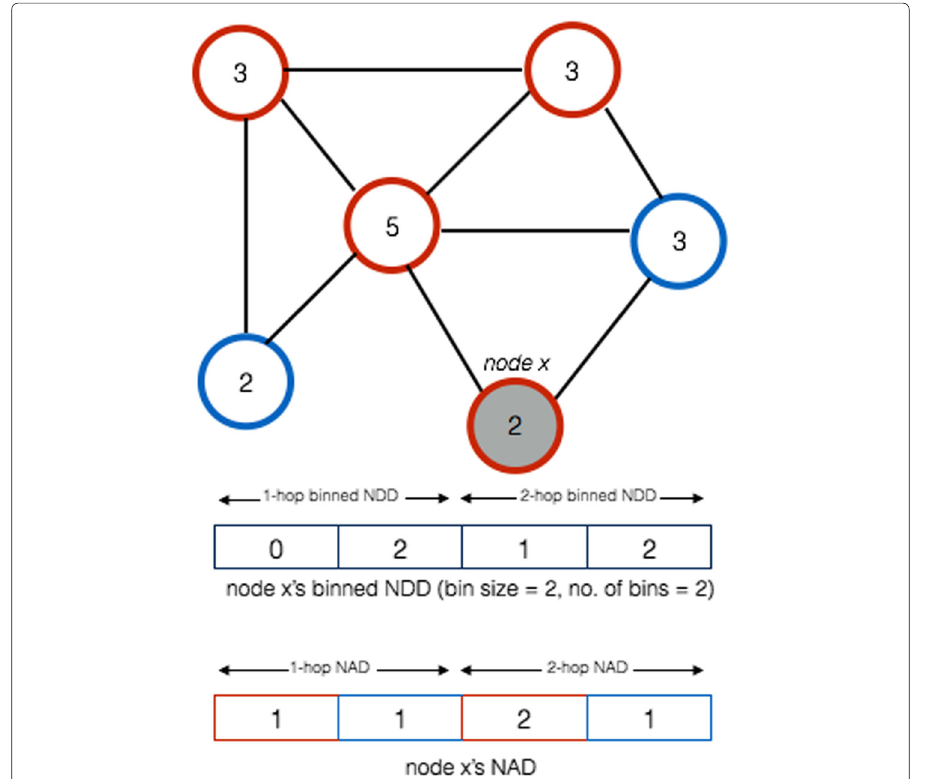
Fig. 2 Example of a node signature defined as a combined feature vector made up from NDD and NAD vectors. In the NDD vector, each bin value corresponds to the number of nodes that have a degree value represented in the bin range, such that the j th bin holds the nodes in the degree ( k j ) range j × b ≤ k j < ( j + 1 ) × b . If the degree exceeds the maximum range, such nodes are included in the last bin. Further, both 1-hop and 2-hop NDDs are calculated and merged. For example, node x has no 1-hop neighbor nodes that have degree in the range of 1 − 2, and one 2-hop neighbor node that its degree is in the range of 1 − 2. In the NAD vector, each element corresponds to the number of nodes with the given attribute. Both 1-hop and 2-hop NADs are calculated and merged. Node x has one 1-hop neighbor node, and two 2-hop neighbor nodes with the attribute Red . Note that the node value represents the associated degree, and the border color represents the node attribute Red or